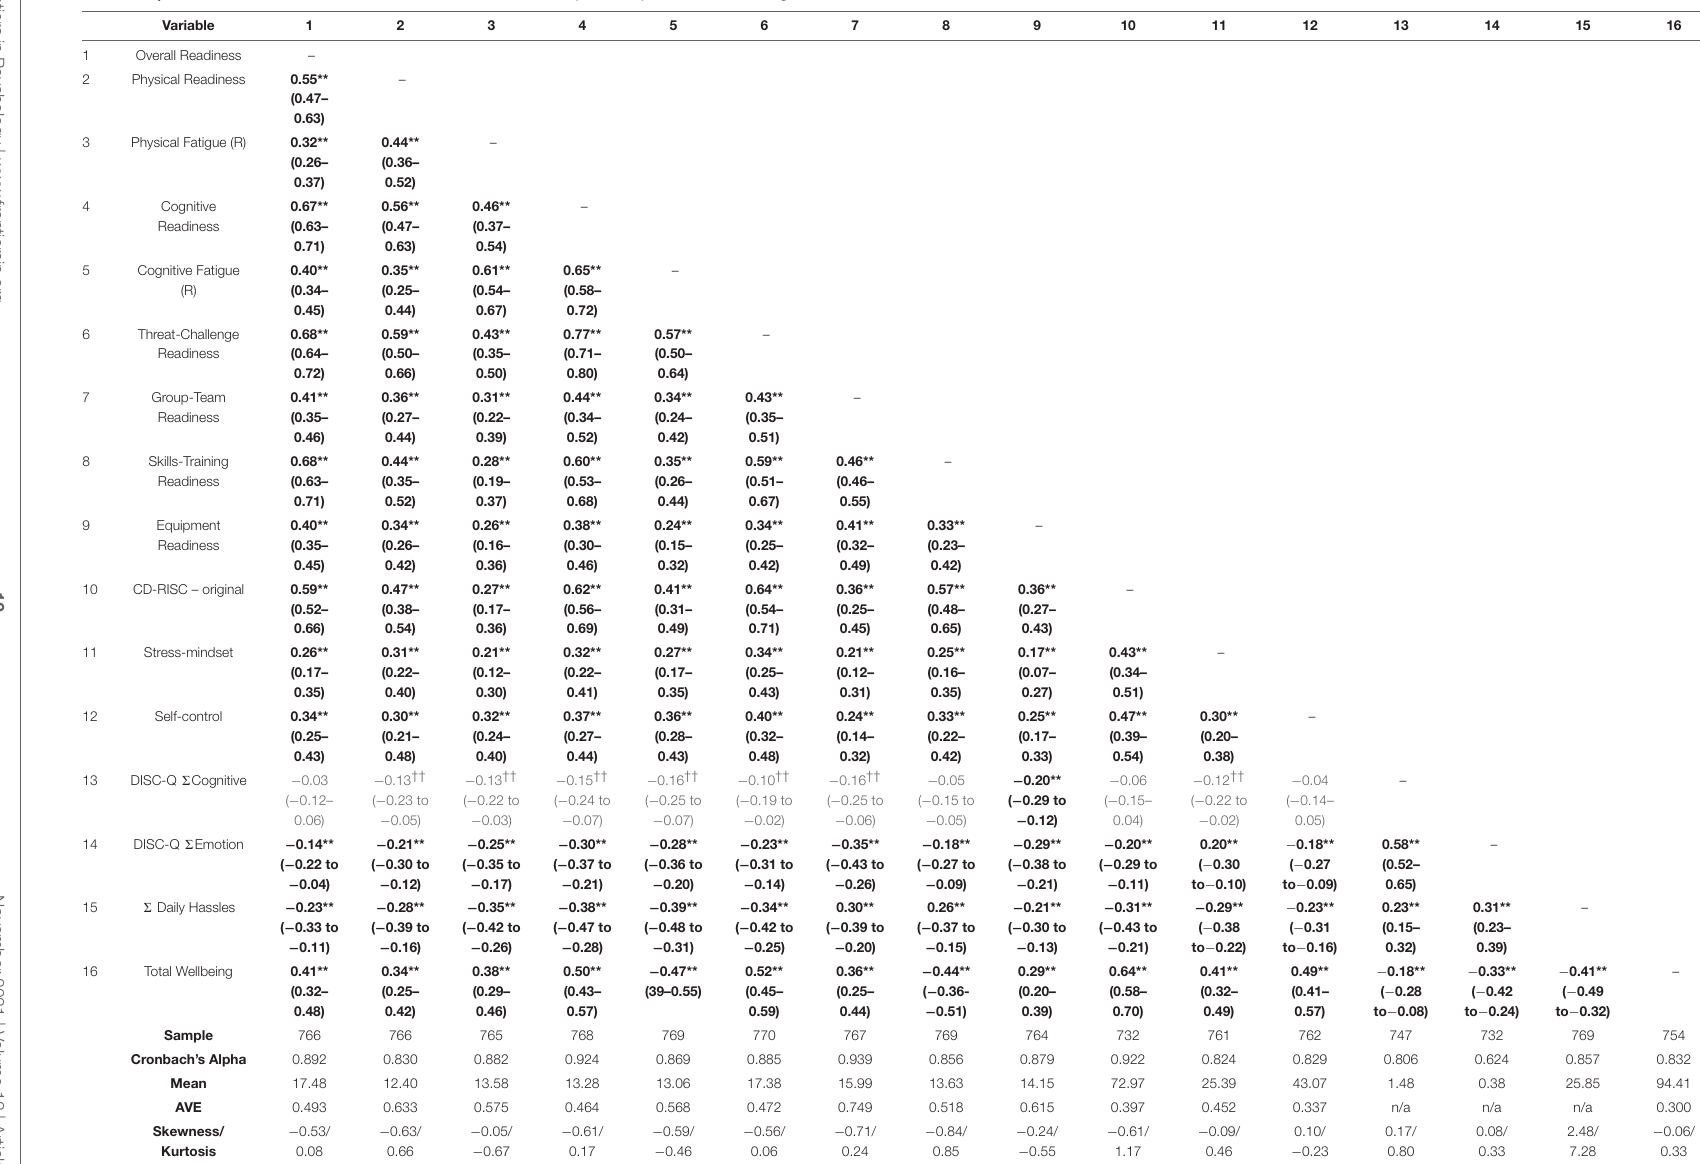
Cells include r-value with 95% confidence-interval values in parentheses. *denotes p < 0.05 and **denotes p < 0.01. We used †† to denote correlations that were statistically significant but with confidence intervals close to including zero. Gray font denotes no meaningful correlation. Black and bold indicates a significant